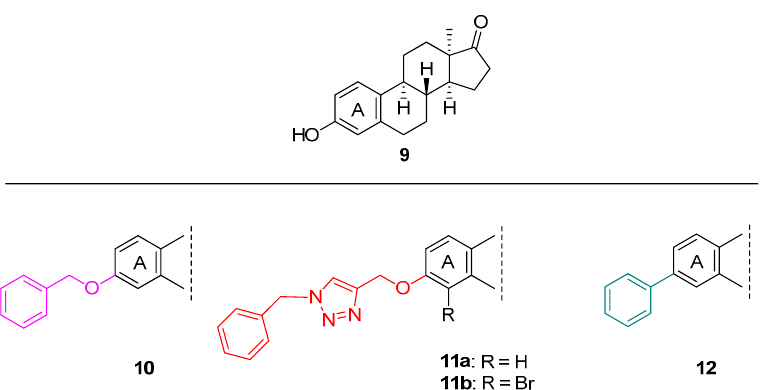
Figure 4. 13 α -Estrone derivatives 9 ‒ 12 synthesized recently (the modifications are indicated by different colours).